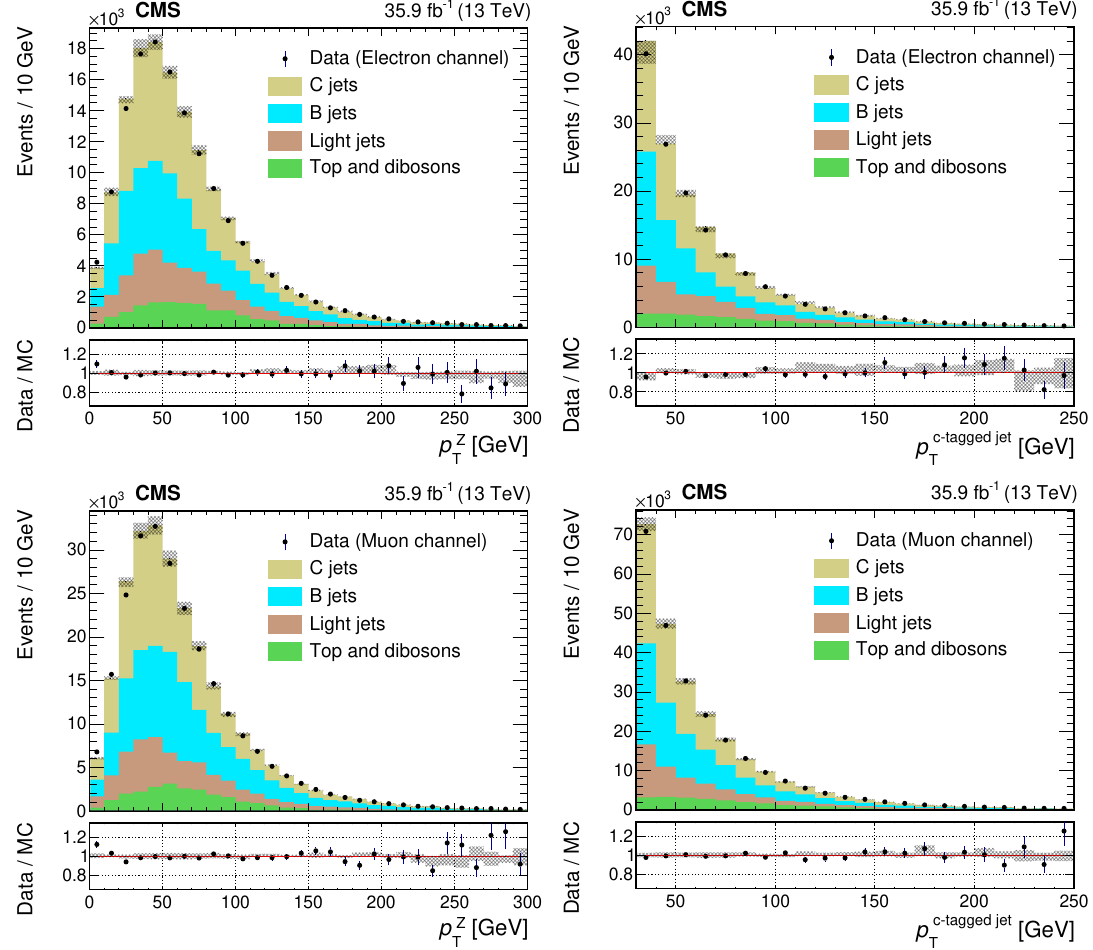
in data and corrected simulation, after applying the fitted scale Figure 4 . The distributions of p T factors to the Drell-Yan components. The upper plots show distributions for the electron channel, with the p of the electron pair (left) and c -tagged jet (right). The lower plots show distributions T for the muon channel with the p of the muon pair (left) and c -tagged jet (right). Dashed area T represents MC systematic uncertainties. The vertical bars on the data points represent statistical uncertainties. Bottom panels on each plot represent the data to MC